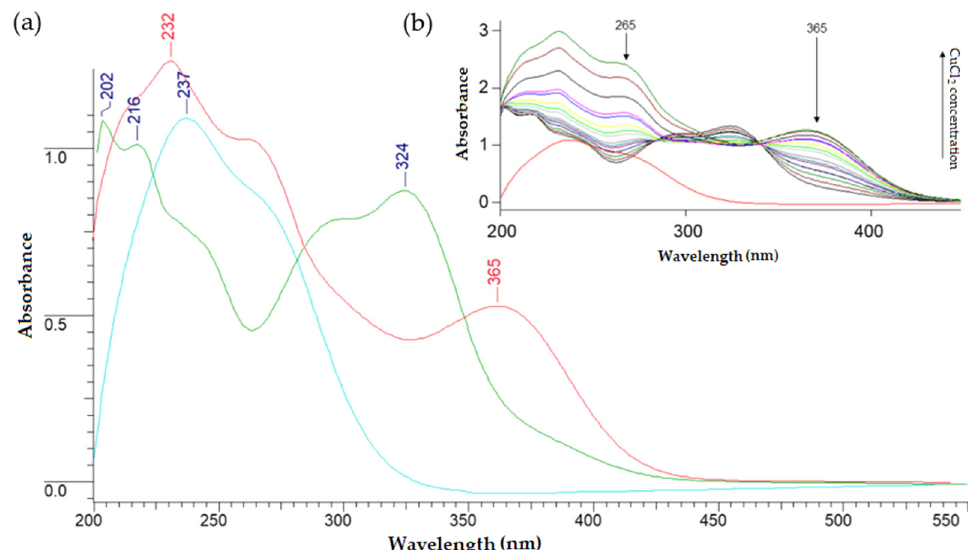
Figure 6. ( a ) The UV-Vis spectra of CuCl 2 in tris-HCl buffer, with C = 10 − 4 M (blue line), 5-CQA in tris-HCl buffer, with C = 10 − 4 M (green line), and copper(II) with 5-CQA complex in 1:1 molar ratio in tris-HCl buffer, with C = 10 − 4 M (red line), recorded in the range of 200–550 nm. ( b ) The UV/Vis spectra of successive series of prepared solutions; the increasing concentration of CuCl 2 is depicted (red line—CuCl 2 spectrum in tris-HCl, with C = 10 − 4 M).